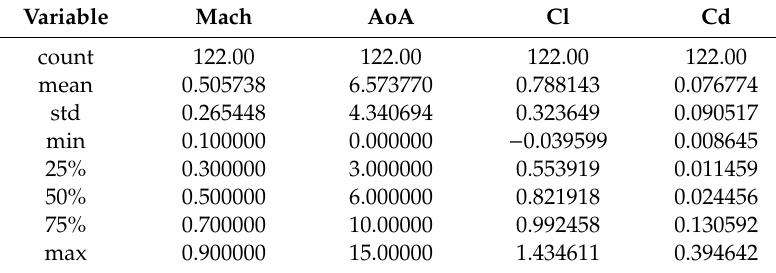
Table 4. Statistics of the aerodynamic database